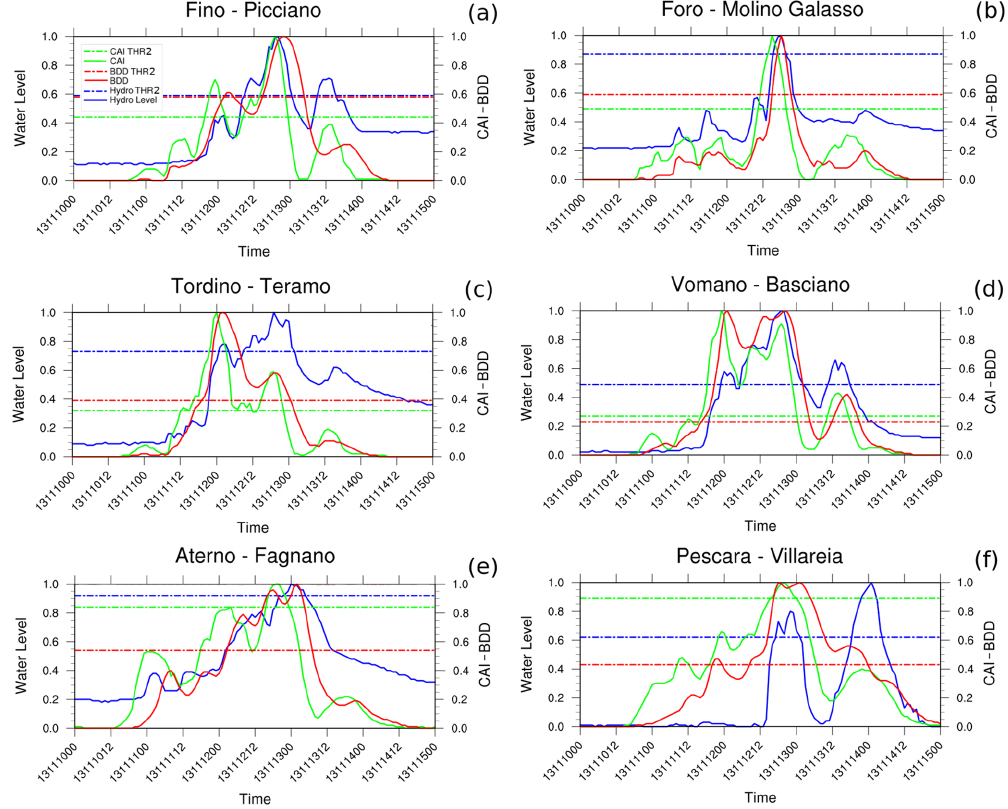
Figure 13. Time series comparison for six hydrometric stations: BDD hourly profile (red line), BDD moderate threshold (flat red line), CAI hourly profile (green line), CAI moderate threshold (flat green line), hydrometric-level hourly profile (blue line) and hydrometric-level moderate threshold (blue flat line). Quantity profiles and related thresholds are